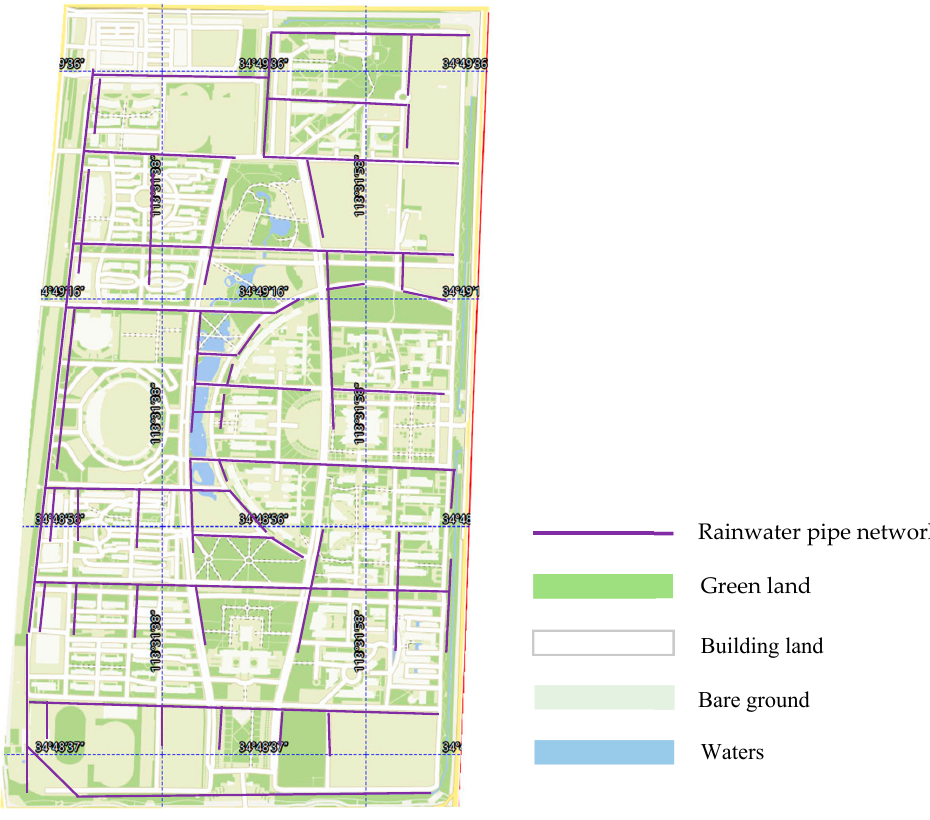
Figure 6. Land use of the study area.